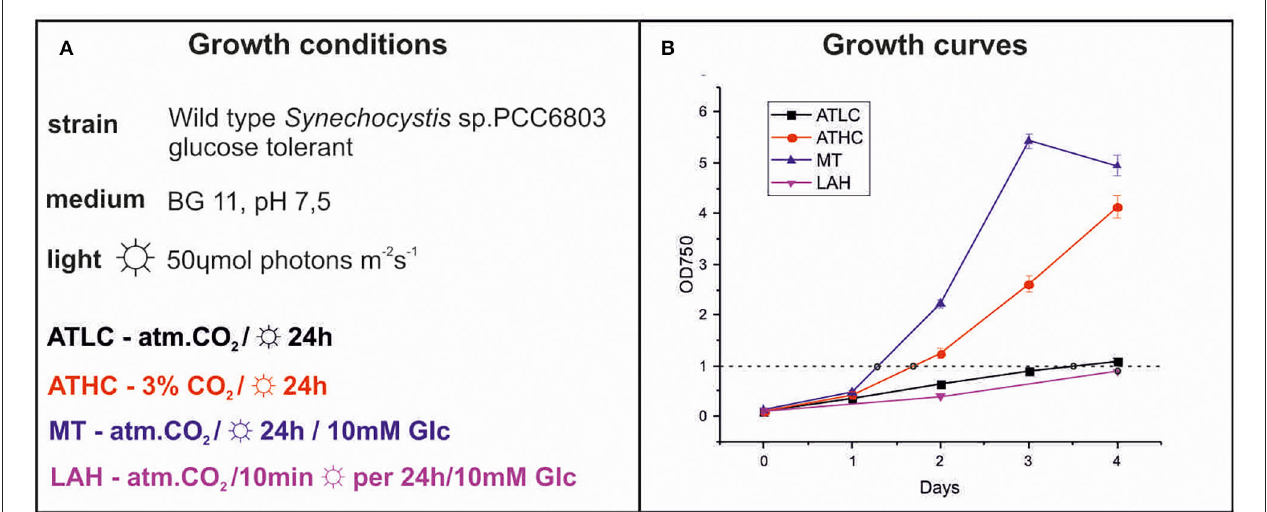
FIGURE 1 | Different growth strategies in Synechocystis cells. Growth conditions (A) and growth dynamics (B) of Synechocystis cells under photoautotrophic at low CO 2 (ATLC; black) and high CO 2 (ATHC; red), photomixotrophic (MT; blue) and light activated growth (LAH; magenta) conditions. The timing of collection of cells for proteomics, when optical density at 750 nm (OD 750 ) 1,0 is marked with black circles. Values are means ± SD; n = 3 biologically independent experiments.